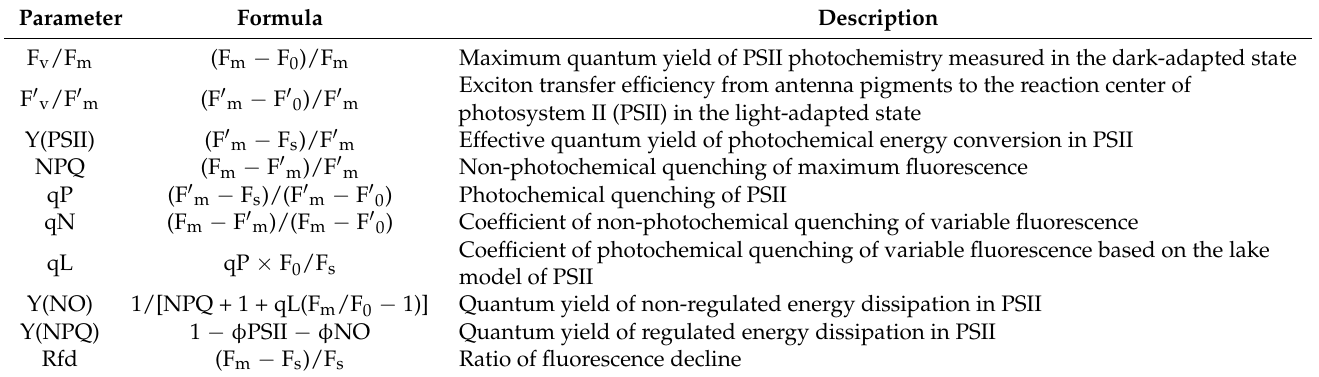
Table 1. Chlorophyll fluorescence parameters used in this